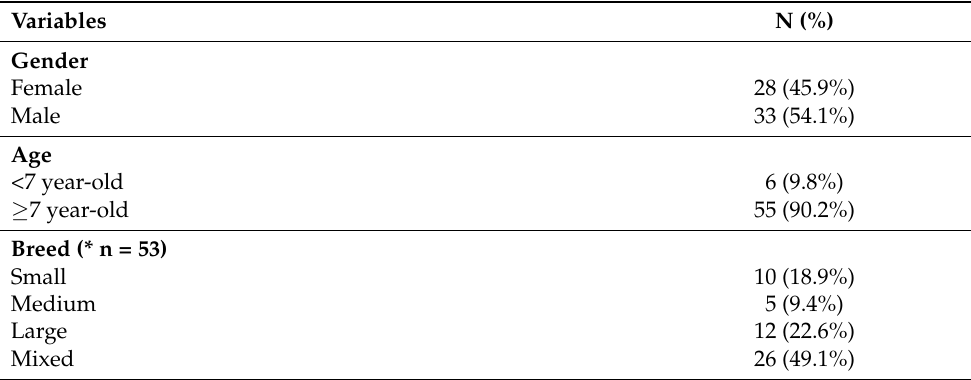
Table 1. Patient characteristics (n =